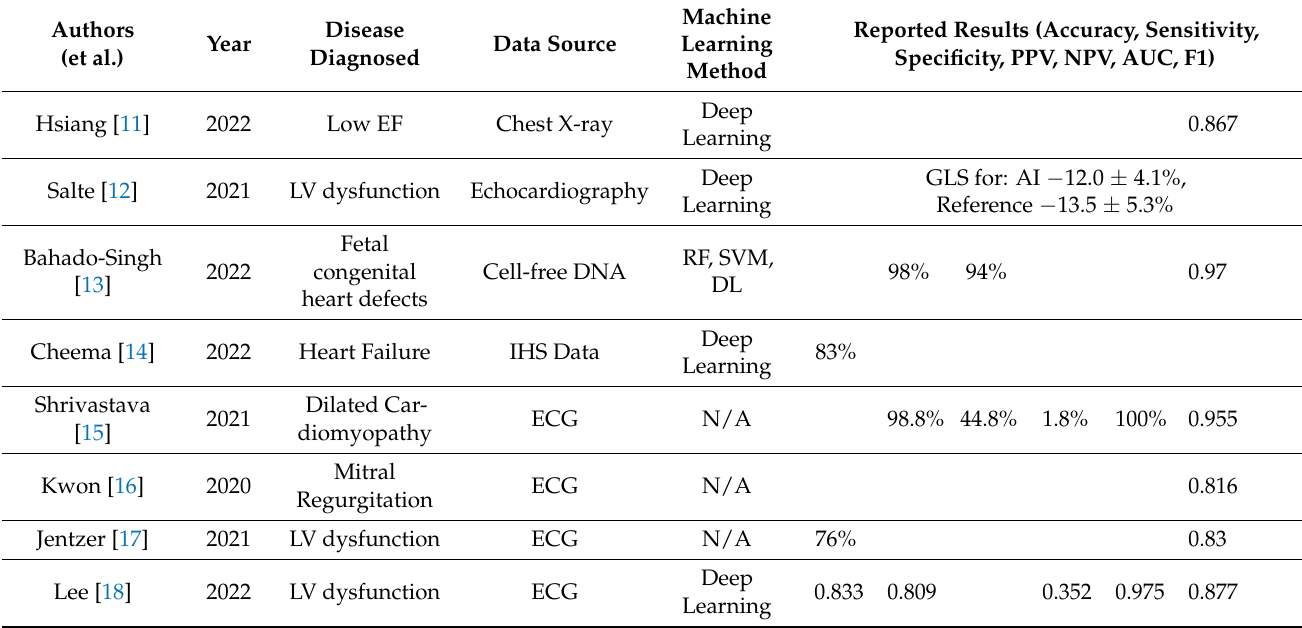
Table 1. Method and performance summary of reviewed